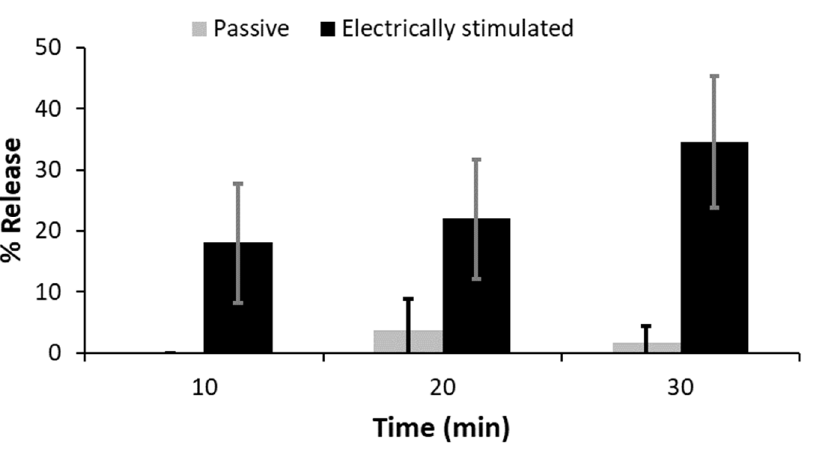
Figure 8. Drug release profiles of hydrogels loaded with PEM. Without electrical stimulation (grey bars) and electrochemically triggered (black bars).